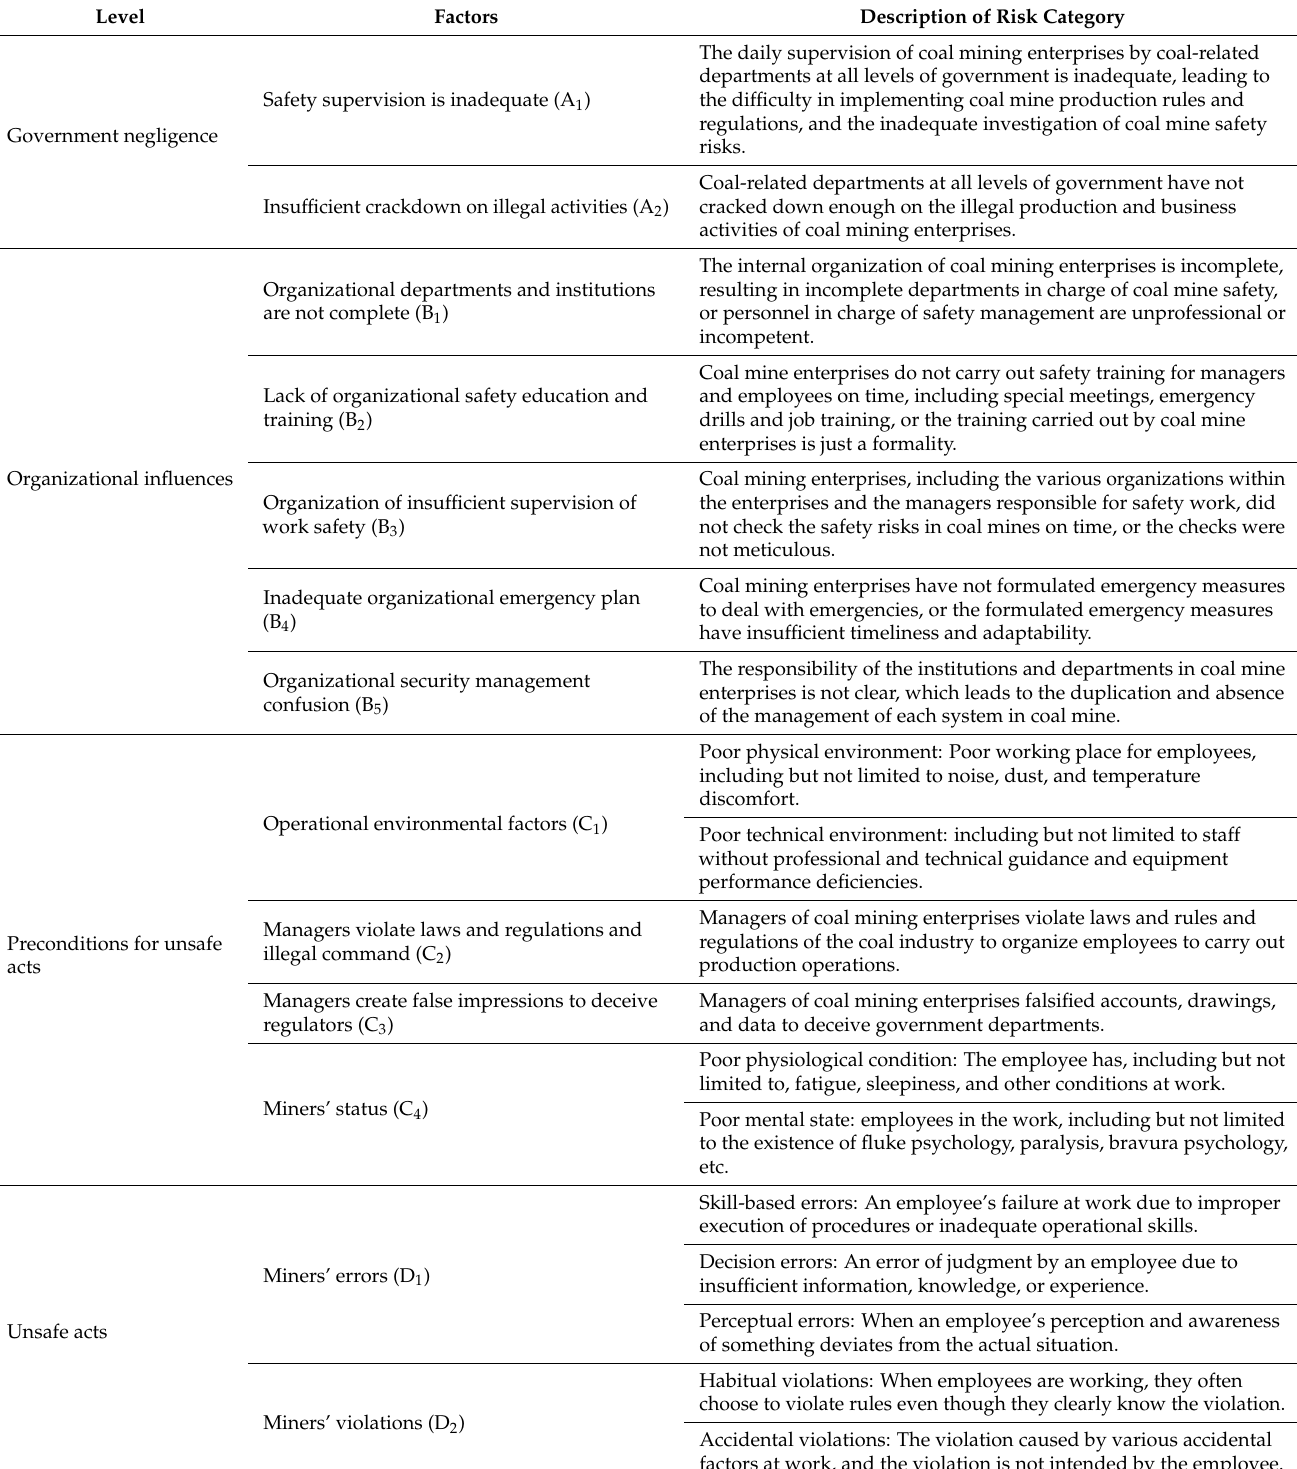
Table 1. Classification categories of